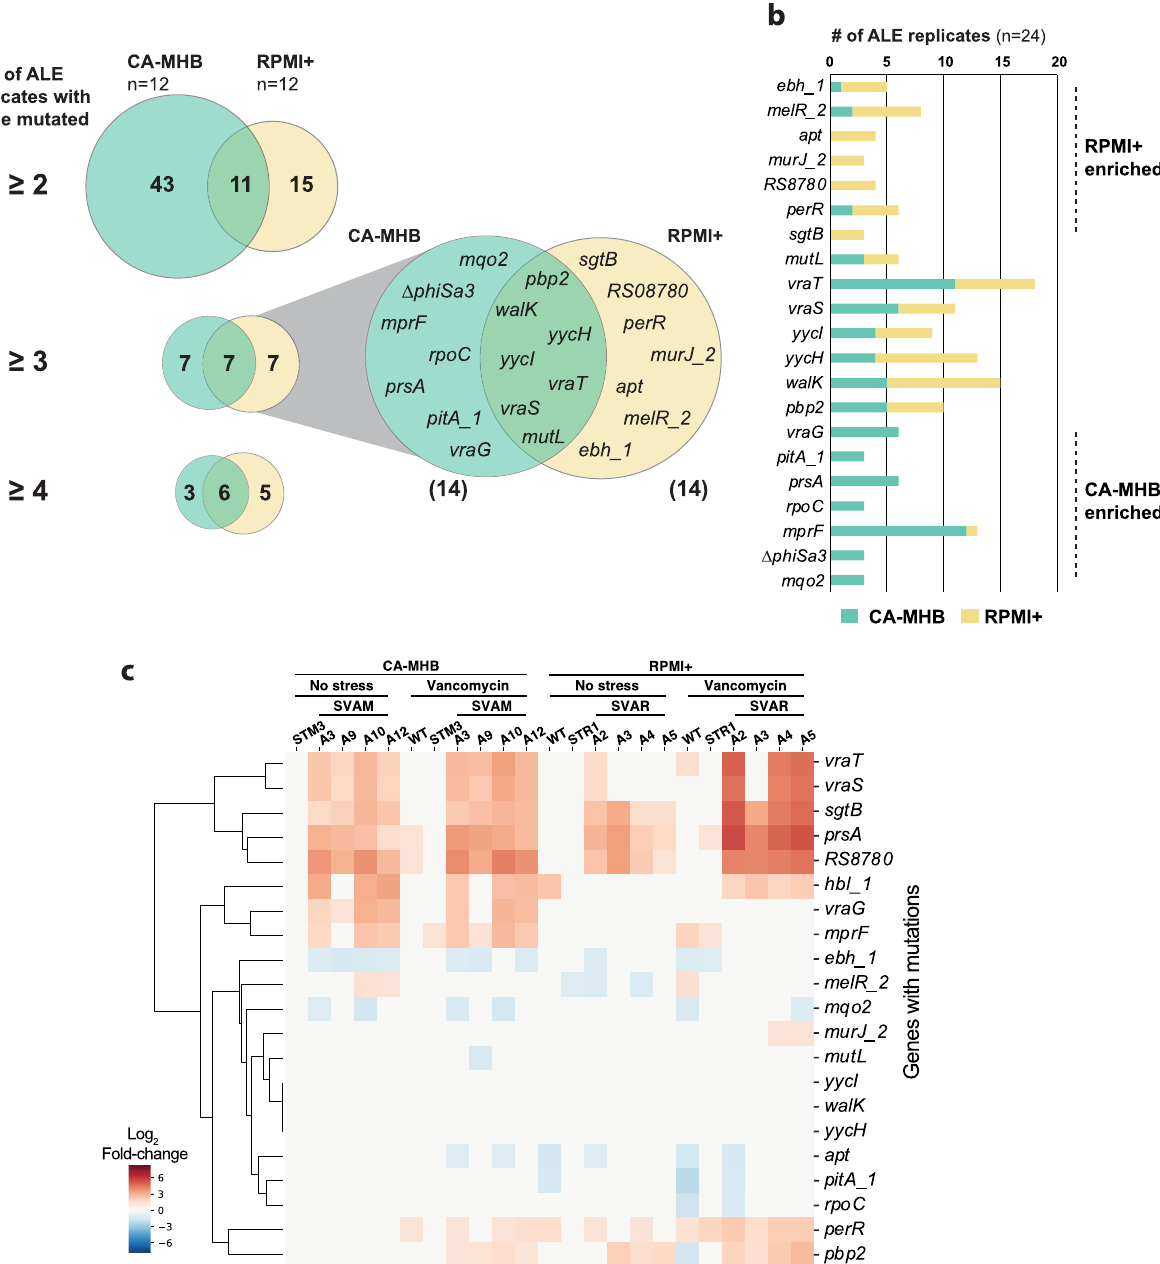
Fig. 3 Key mutations found in MRSA during vancomycin tolerization. a Venn diagrams of the number of key mutated genes in the two utilized media conditions (i.e., CA-MHB and RPMI + ). b A bar plot of the number of lineages with mutations in a key mutated gene, n = 24 lineages, 12 for each media condition. c A heatmap of RNAseq expression level of key mutated genes in a selection of starting and TALE-derived strains, in the presence and absence of vancomycin. STM: Staphylococcus aureus adapted to CA-MHB. STR: Staphylococcus aureus adapted to RPMI + . SVAM: Staphylococcus aureus tolerized to vancomycin in CA-MHB. SVAR: Staphylococcus aureus tolerized to vancomycin in RPMI +